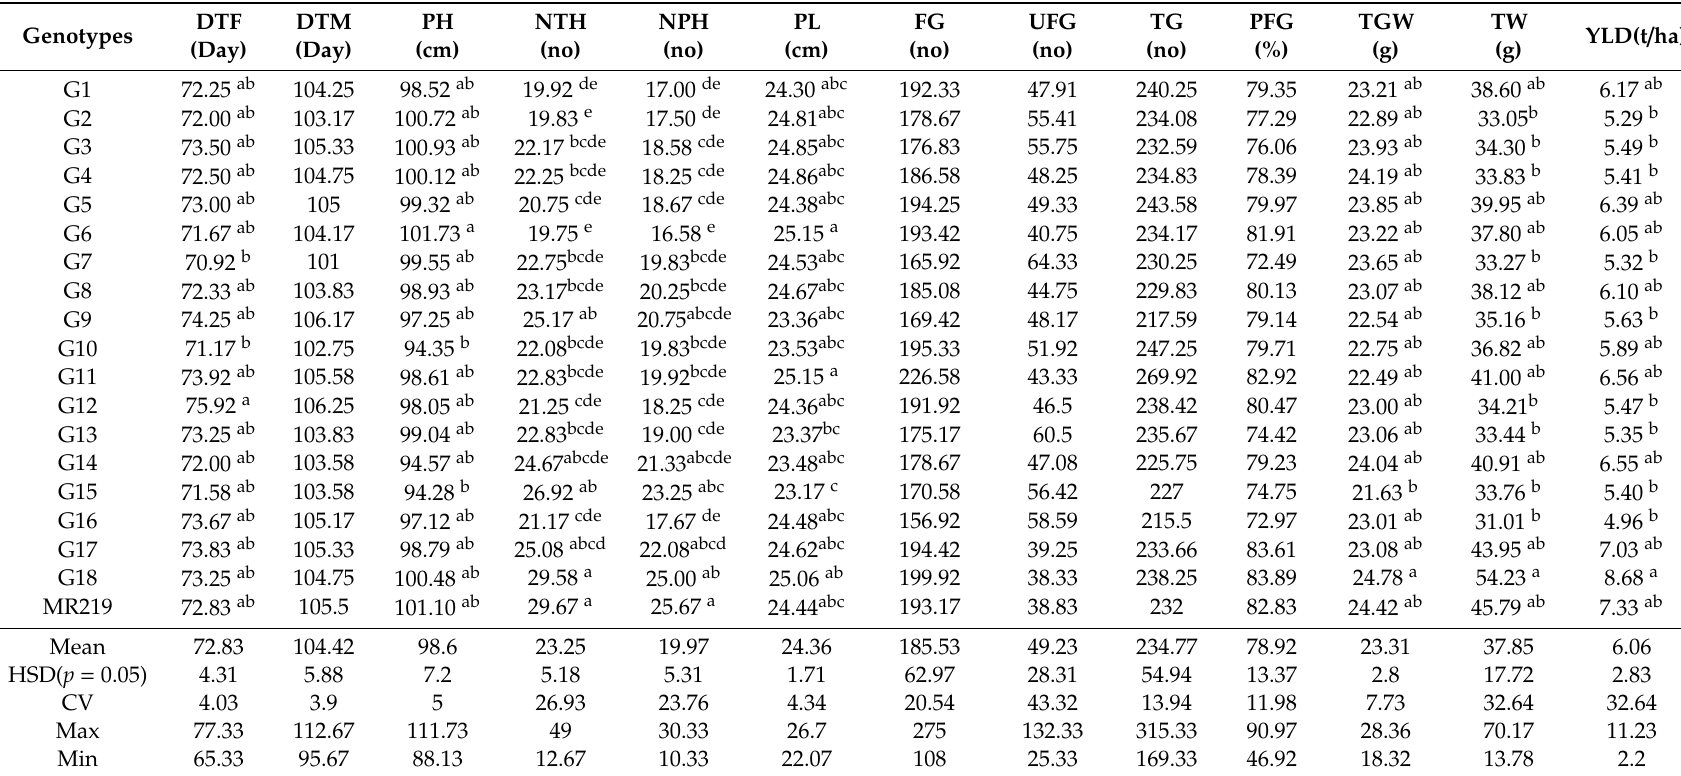
Table 3. Mean for 13 traits of 19 rice genotypes tested in four